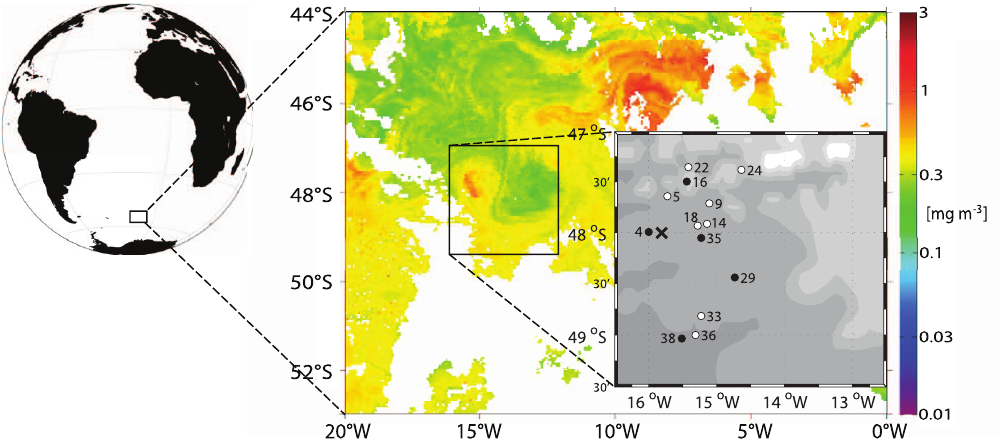
Figure 1. Map and sampling scheme of LOHAFEX. MODIS (Moderate Resolution Imaging Spectroradiometer) satellite image from 14. February 2009 showing chlorophyll a concentrations for the Polar Frontal Zone with the LOHAFEX bloom encircled. Stations and experiment days of both the IN (black) and OUT stations (white) are shown in the small map. The X marks day 2 1 before the iron addition on 27 th January. The globe and the inset map were generated with the M_Map package for Matlab (version 7.12.0.635; MathWorks, Natick, MA). The chlorophyll a data were downloaded from the NASA website http://oceancolor.gsfc.nasa.gov/.